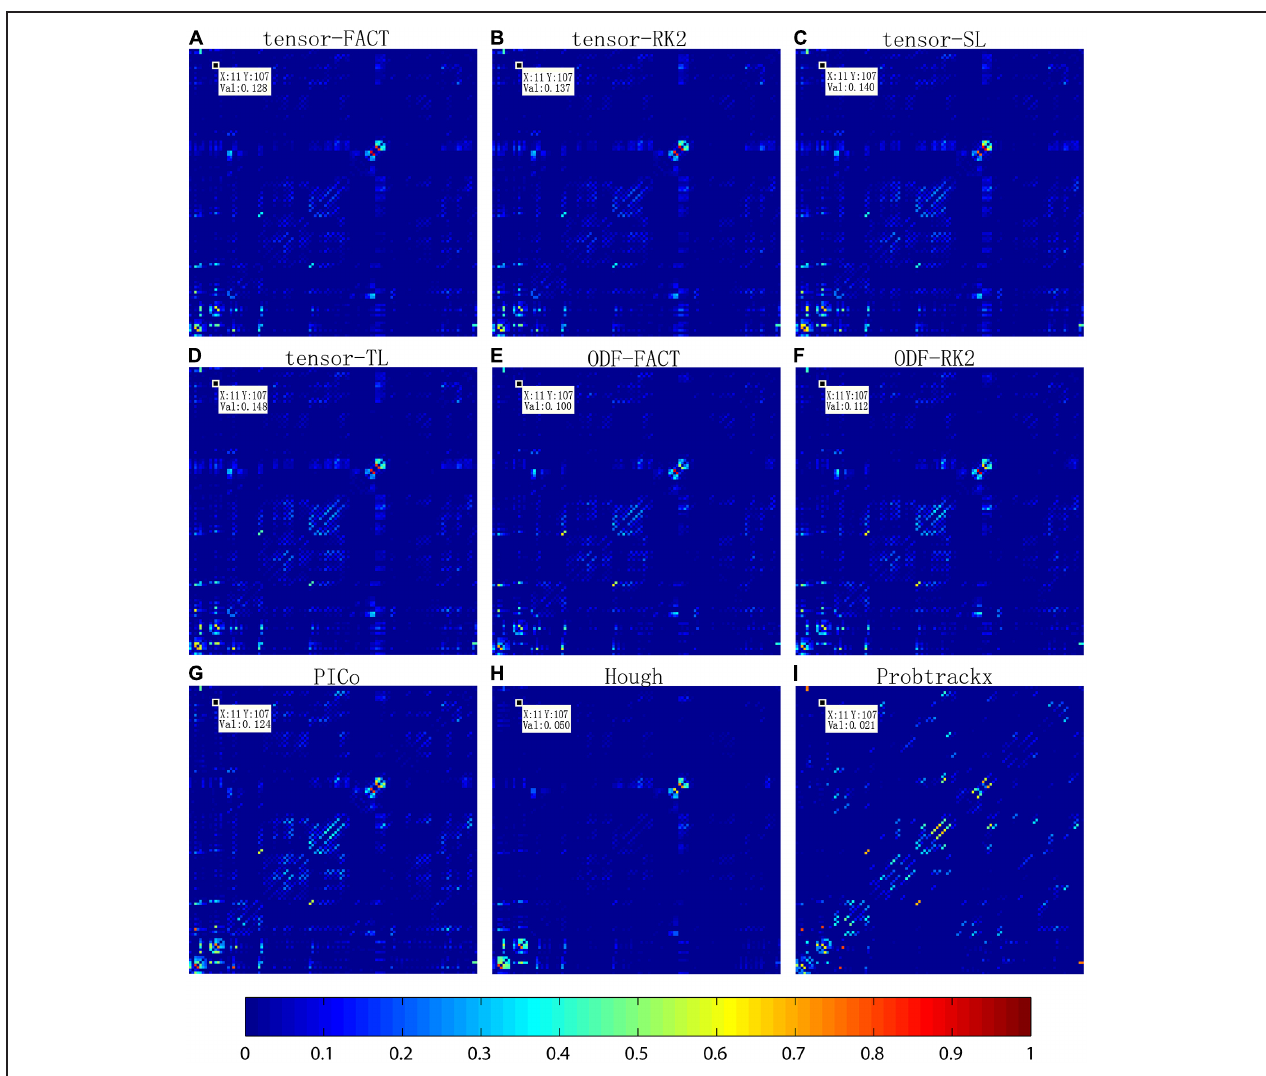
FIGURE 2 | Comparison of averaged normalized brain networks from nine different tractography algorithms, including (A) tensor-based FACT; (B) tensor-based RK2; (C) tensor-based SL; (D) tensor-based TL; (E) ODF-based FACT; (F) ODF-based RK2; (G) ODF-based PICo; (H) ODF-based Hough, and (I) Ball-and-stick model based Probtrackx, from all 202 subjects. In each network, each cell